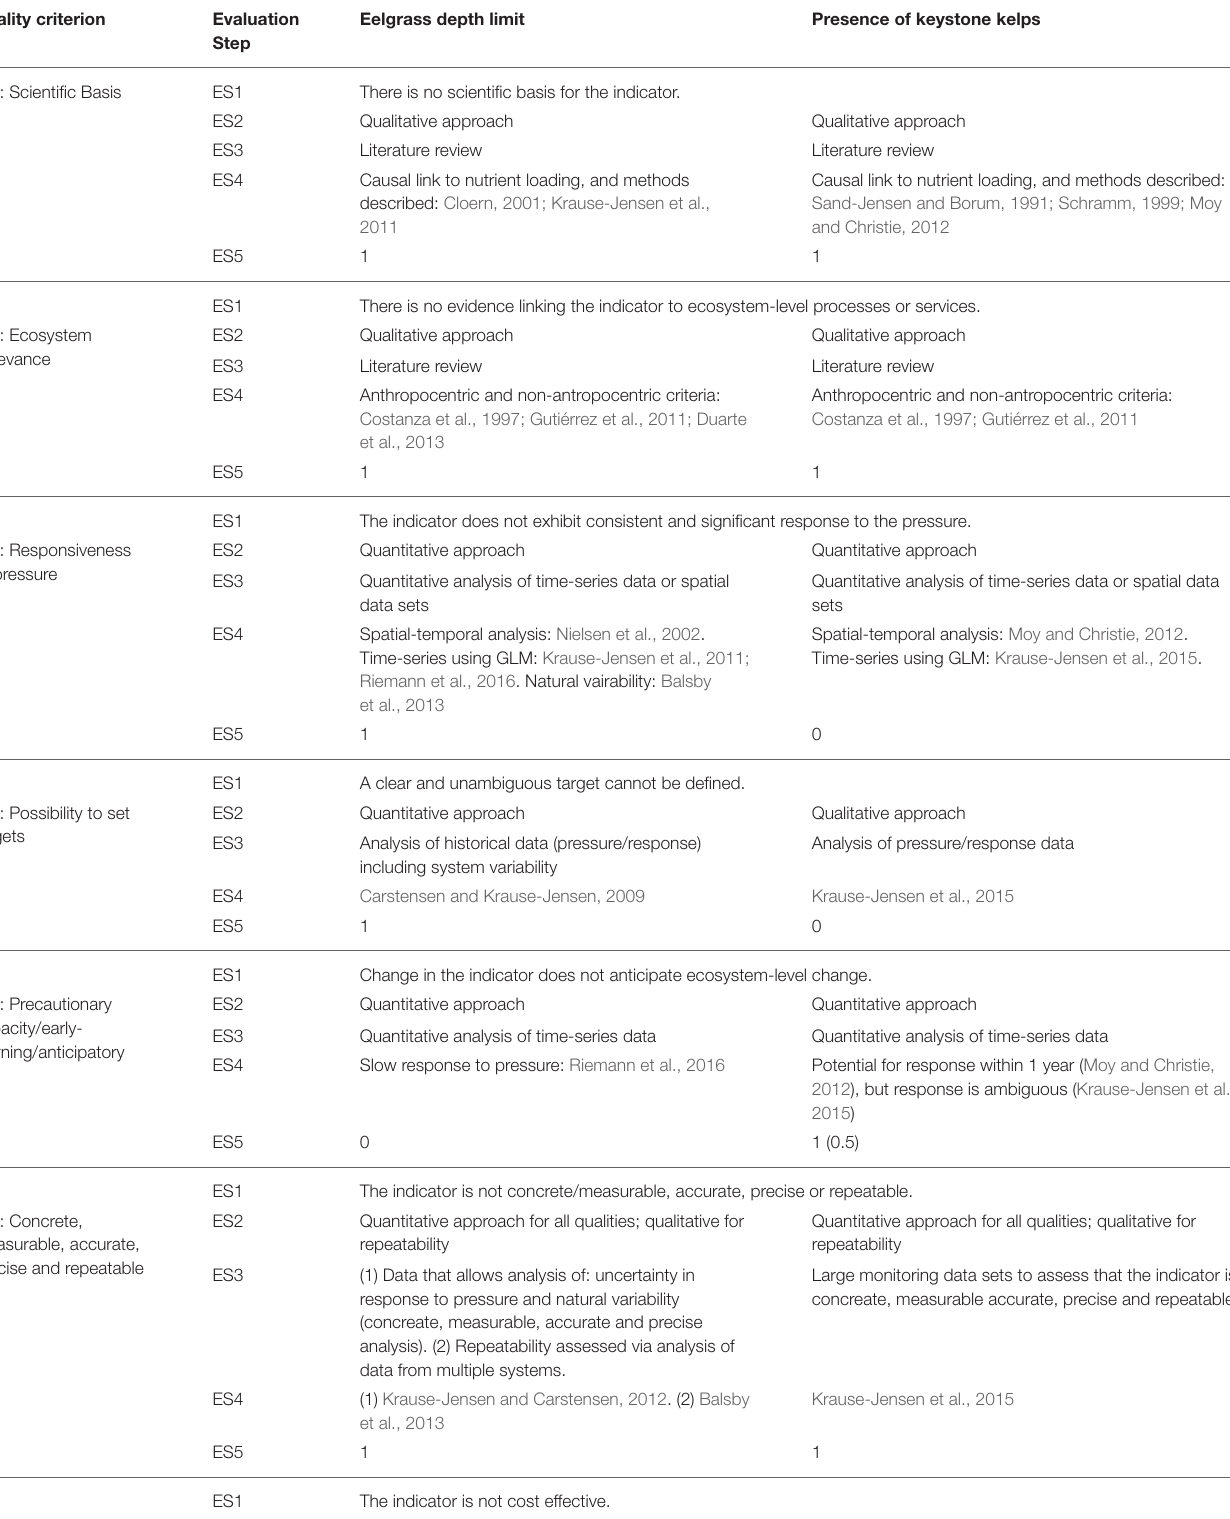
TABLE 3 | Summary of quality assessment of the candidate benthic vegetation indicators “Presence of keystone kelp species” and “Eelgrass depth limit,” both relating to the MSFD indicator category “Distributional pattern (1.4.2), in association with the GEnS descriptors 1 and 5. Quality